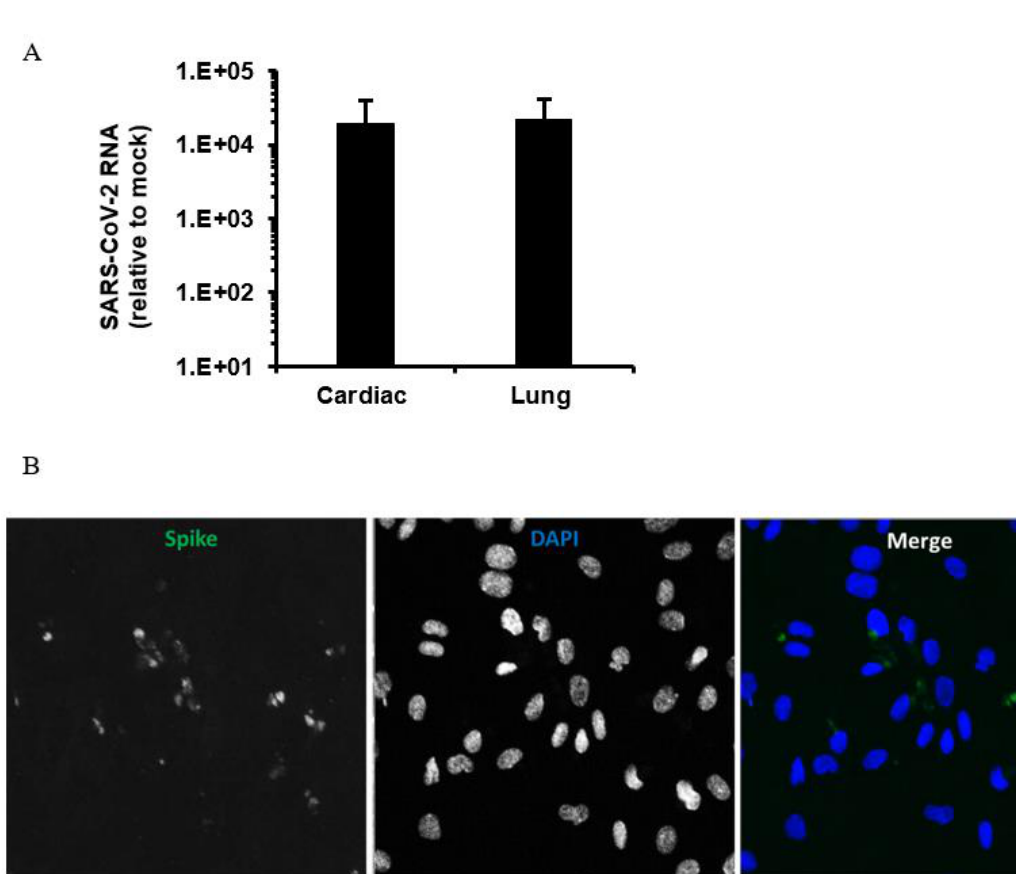
Figure 2. SARS-CoV-2 infects human endothelial cells. ( A ) Human primary lung and cardiac microvascular cells were infected with SARS-CoV-2 (MOI = 3) for 48 h followed by cell lysates collection for RNA isolation and qRT-PCR using SYBR Green (Quanta BioSciences). Viral spike protein expression was quantitated using a Bio-Rad CFX96 Touch System. Values are expressed as the mean of three independent experiments. Error bars represent standard errors of the mean. ( B ) Representative confocal imaging (20X) of human primary lung microvascular cells infected with SARS-CoV-2 (MOI = 3) for 48 h. After fixation, coronavirus-infected cells were stained using mouse monoclonal antibody to SARS spike protein (GeneTex) and Alexa Fluor 488 donkey anti-mouse (Invitrogen). Nuclei were stained with DAPI. Confocal images were acquired using Olympus 1x81 spinning disk confocal microscope with Volocity 6.2.1 software.